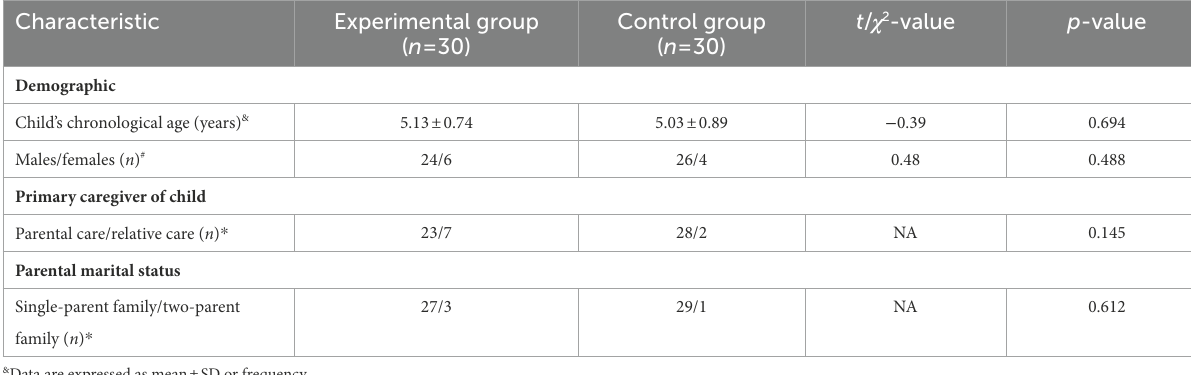
TABLE 1 Baseline demographic and clinical characteristics.